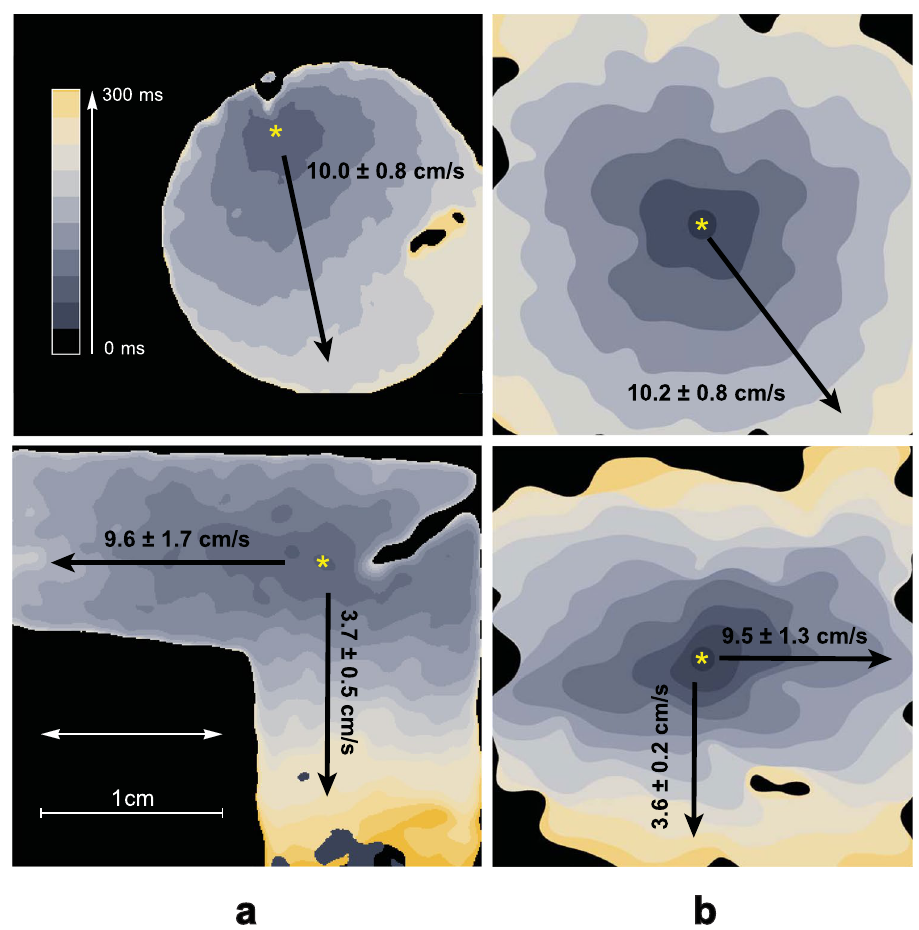
Figure 6. Experimental results acquired with the optical mapping of isotropic and anisotropic samples compared to simulated ones. ( a ) Activation maps for the isotropic sample (upper image) and the anisotropic sample on nanofibers (lower image). The yellow star shows the place where stimulation with an electrode was applied. The white arrow shows the preferred direction of the fibres in the sample. Activation time is colour coded (0–300 ms). ( b ) Corresponding simulations of the wave propagation in samples with 30% and 35% FBs in isotropic and anisotropic samples, respectively. The same filters with the same kernel size were applied to the simulated data, as for the experimental data in column ( a ). Corresponding video files and extended version of this figure could be found in Supplementary